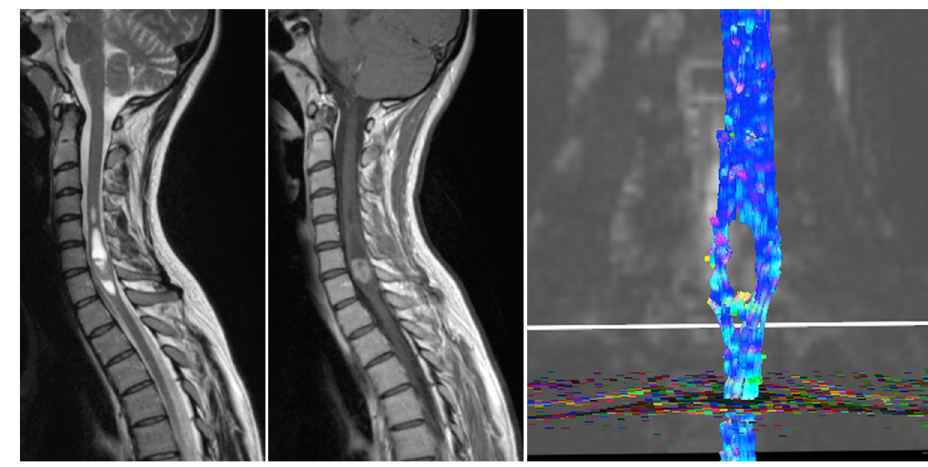
Fig. 6 DTI for surgical planning. Patient with an ependymoma in the lower cervical spinal cord with areas of high T2 signal ( a ) and enhancement after gadolinium administration ( b ). DTI shows displacement of the fibres ( c ), which is usually consistent with a slow-growing